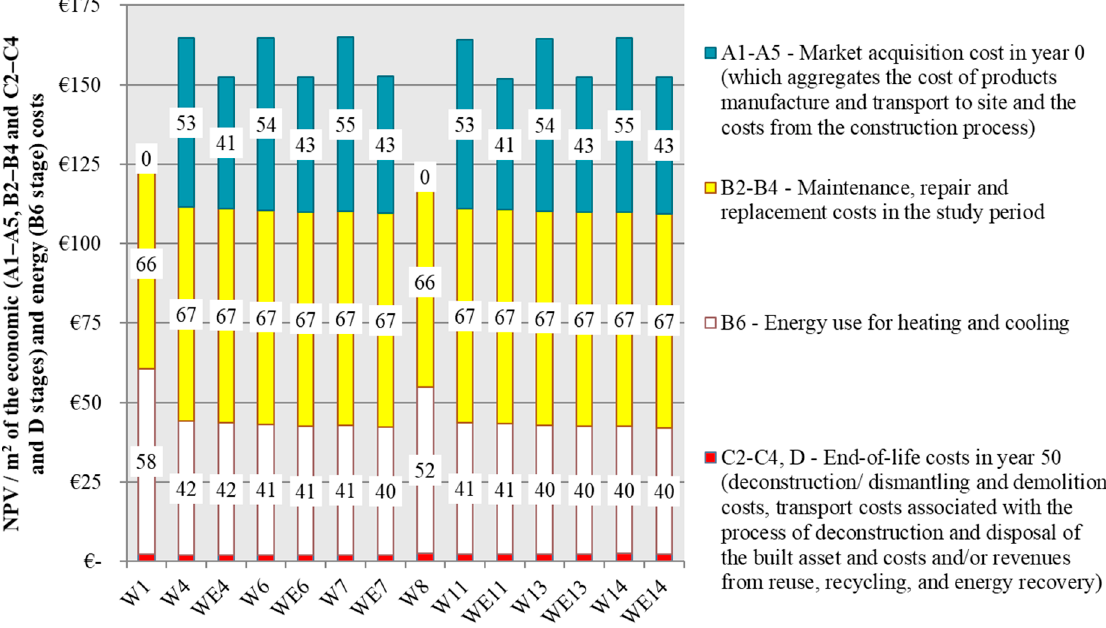
Figure 9. NPV/m 2 of external wall of the economic (A1–A5, B2–B4 and C2–C4 and D stages) and energy (B6 stage) costs of ETICS with ICB and EPS.